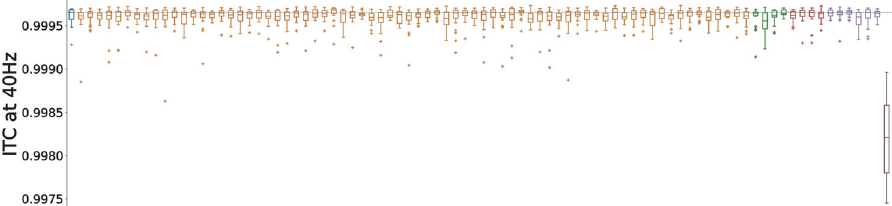
Fig. 6 Overview of 4040 inter-trial coherence for all variants. Control network in blue, blue dashed line represents the mean of the control group, Ca 2 + channel model variants affecting Ca HVA in yellow, Ca 2 + channel model variants affecting Ca LVA in green, HCN model variants in red, SCN model variants in purple, the reduction of g max in brown and increased IPSC times in steel pink. For each color-coded group of variants the ordering matches the ordering in Supplementary Tables 3, 4 and 5, respectively. Solid line represents the mean, box edges the 25 and 75 percentile, respectively, the whisker extend to 2 standard deviations and + depict outliers. the dashed blue line depicts the mean of the control